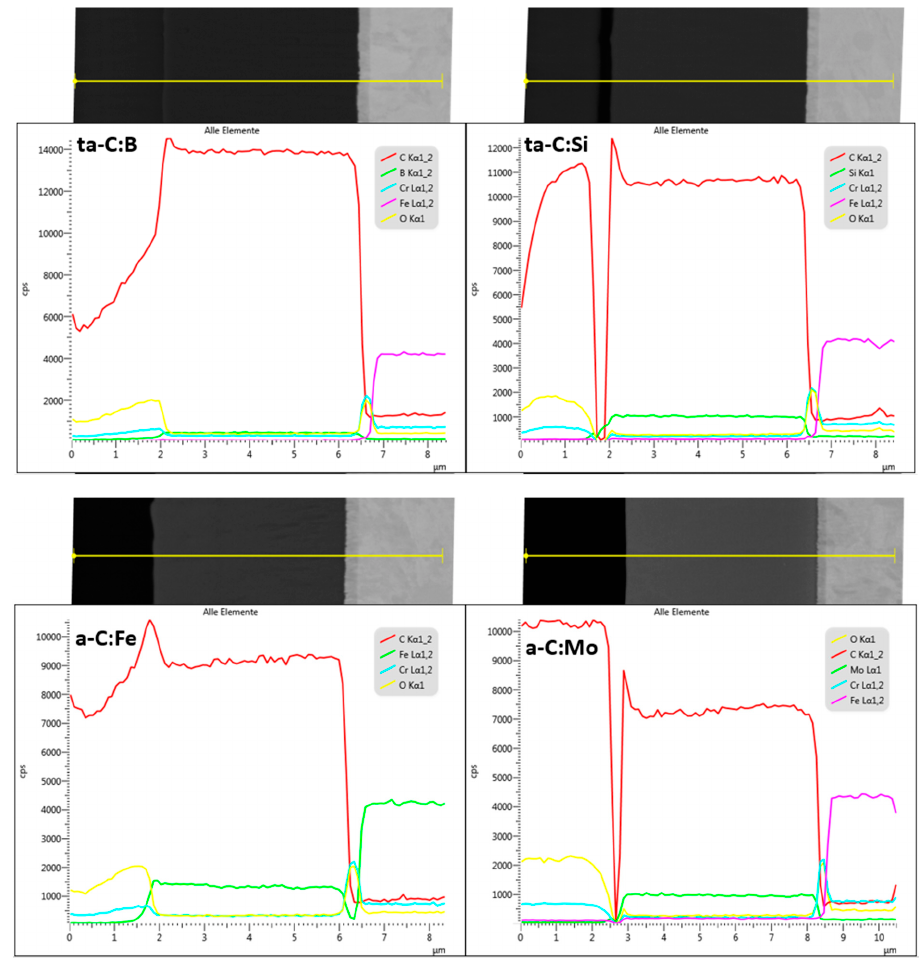
Figure 4. EDS line scan measurements with the signals of the identified elements (see colored lines) on cross ‐ sections of doped carbon coatings. In the SEM pictures, the indexed position of the line scan is shown (yellow lines; scale bar of SEM pictures corresponds to the X ‐ axis).